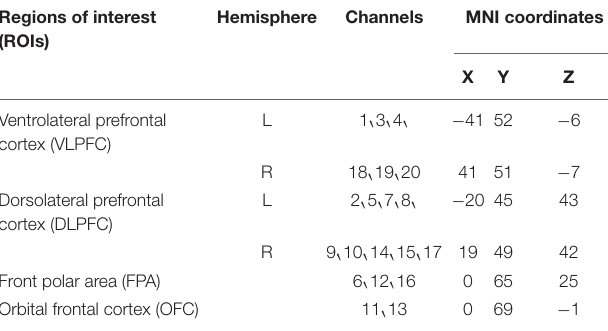
TABLE 2 | Location for each channel.